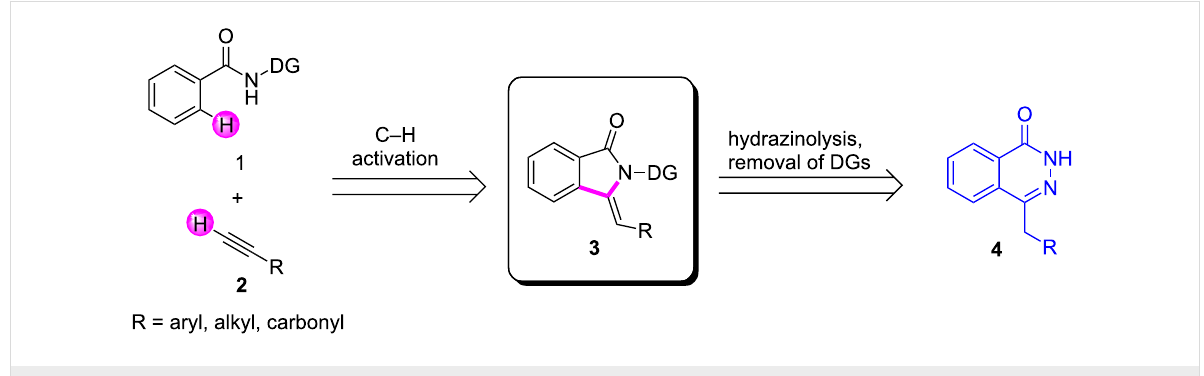
Scheme 1: The construction of phthalazin-1(2 H )-one scaffold via C–H